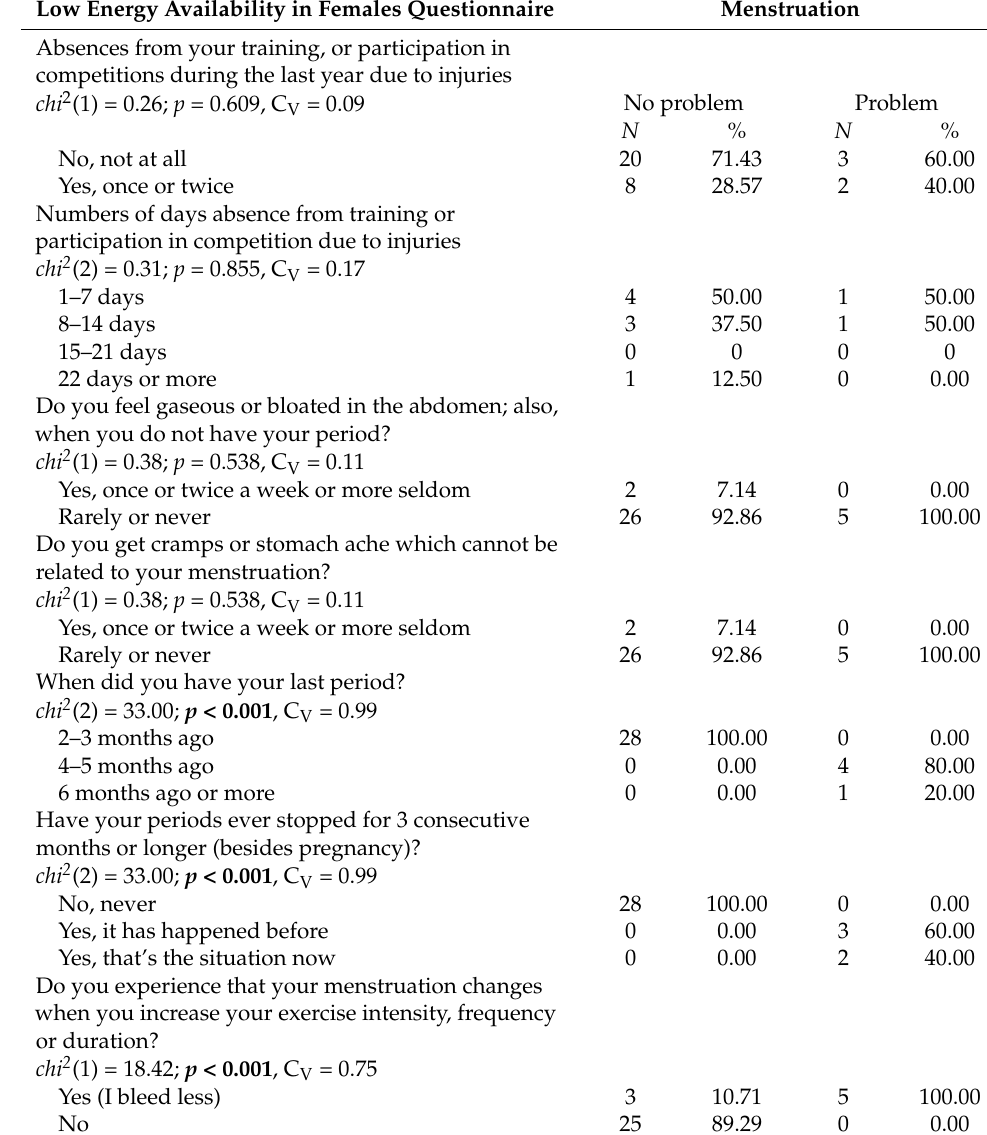
Table 3. Responses to key components of LEAF-Q in relation to menstruation (chi-square tests). Low Energy Availability in Females Questionnaire Menstruation Absences from your training, or participation